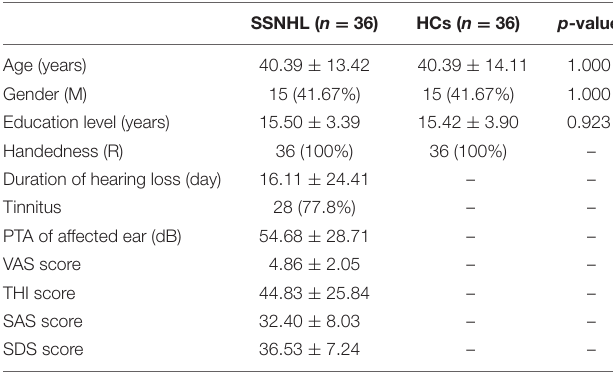
TABLE 1 | Demographics and clinical characteristics of unilateral SSNHL patients and